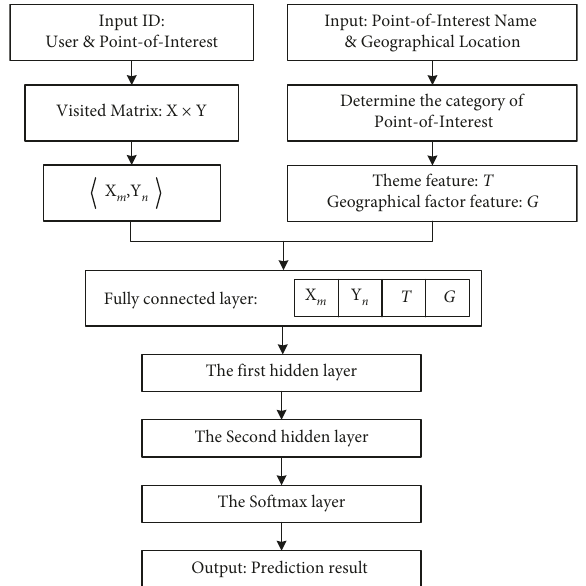
Figure 3: Basic architecture of the proposed network